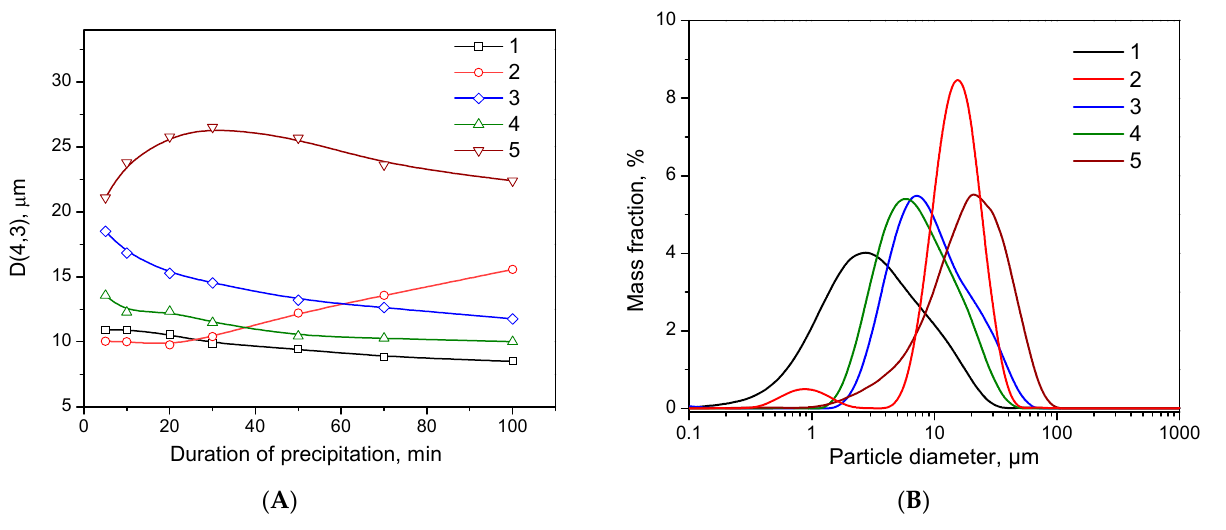
Figure 1. Dependence of the average particle diameter on the precipitation duration ( A ) and particle size distribution at the end of precipitation ( B ): (1) Al-5; (2) Al-6; (3) Al-7; (4) Al-8 and (5) Al-9.